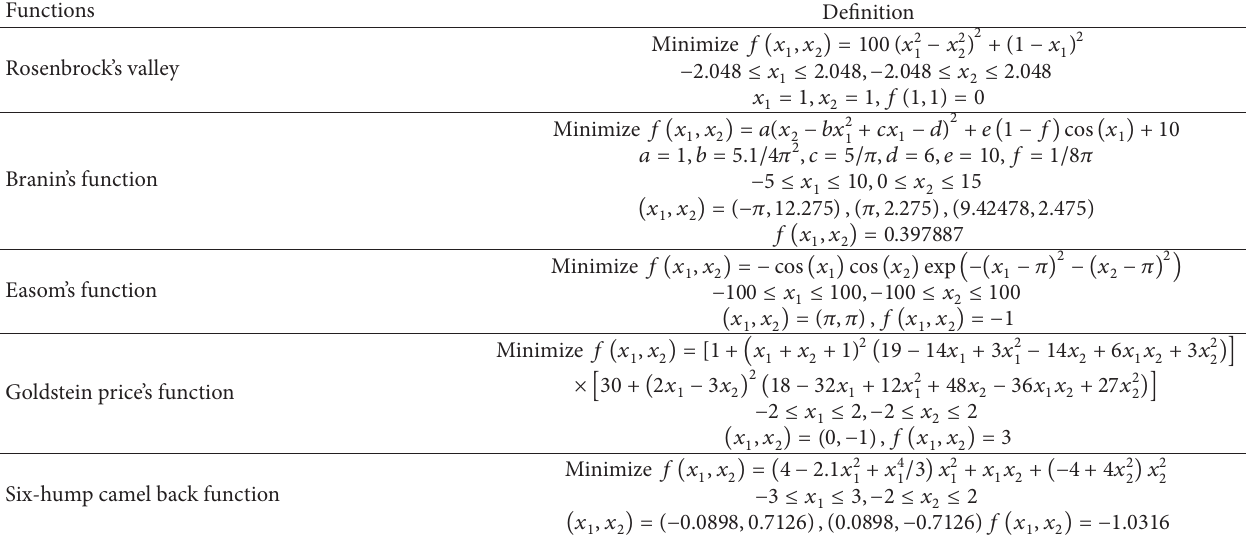
Table 2: Definitions and specifications of two design variables